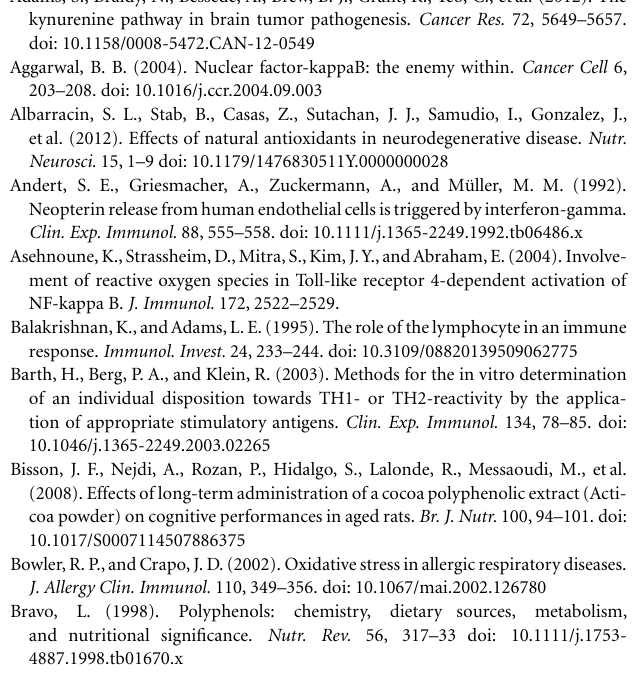
FIGURE 4 | DuringTh1-type immune response, activatedT-cells and natural killer (NK) cells release large amounts of the inflammatory cytokine interferon- γ (IFN- γ ), which triggers various immunoregulatory and anti-proliferative activities in target cells like macrophages (M (cid:2) ) and dendritic cells (DC). Indoleamine 2,3-dioxygenase (IDO) converts tryptophan into kynurenine. In parallel GTP-cyclohydrolase I (GCH) is